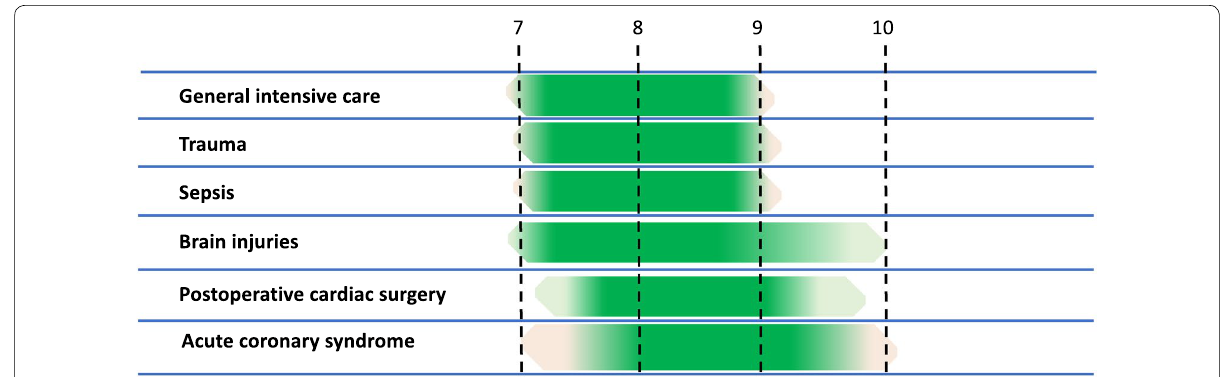
Fig. 2 Target haemoglobin in the case of transfusion (Expert opinion). The following figure proposes target Hb levels for transfusion in critical care patients, as a function of various clinical settings (i.e. the haemoglobin level below which (lower bound) single‑unit transfusion is probably recommended to achieve Hb not exceeding the upper bound). The shaded zones on the figure represent the degree of uncertainty according to the experts, which is why this figure is proposed on the basis of expert opinion. The GRADE level of recommendation is indicated for each setting, in accordance with the above recommendations (R2.1 to R2.4). Note that these targets apply in the absence of active bleeding or poorly tolerated anemia, especially with cardiovascular